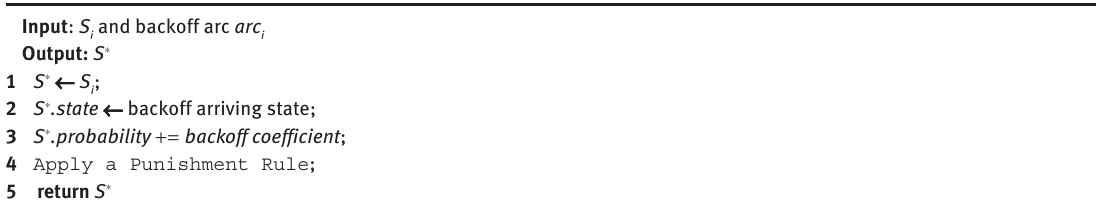
Algorithm 2: Pass Backoff